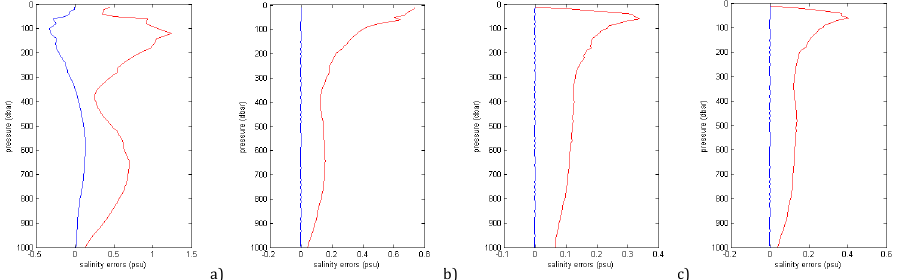
Fig. 2b. Hindcast salinity mean bias errors (blue) and standard deviation errors (red) for different configurations of the mEOF-r technique (see text for the details): (a) mEOF-r( T - S -SHH), (b) mEOF-r( T - S -SH) SST-SSH , (c) mEOF-r( T - S -SH) SSS-SSH and (d) mEOF-r( S -SH).